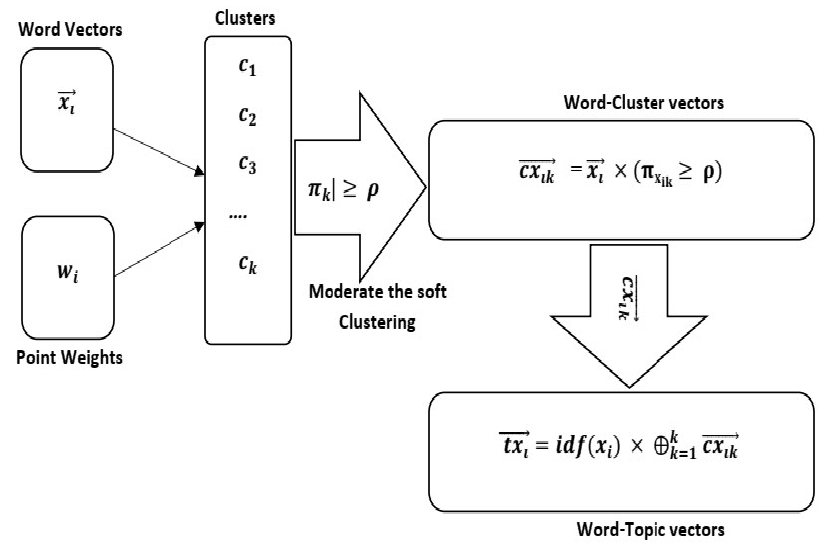
Figure 1. Topics formation using moderate clustering and corpus